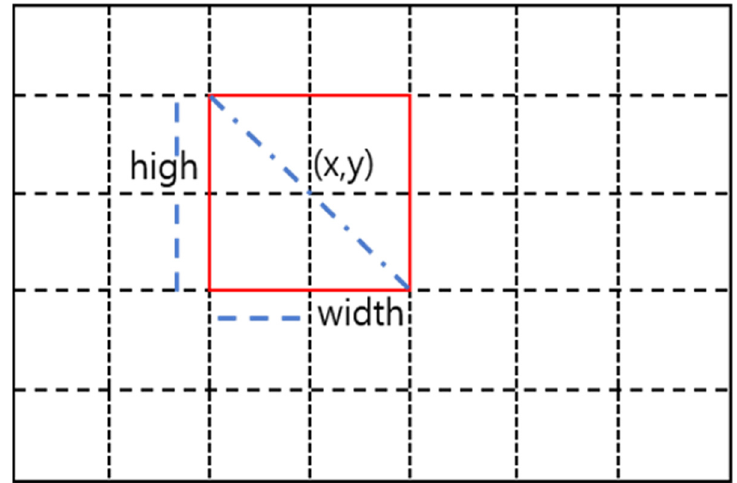
Figure 18. Location calculation by area.